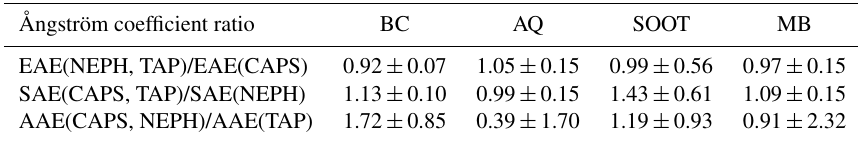
Table 12. Ensemble averages and standard deviations for the instrument-to-instrument ratios of the Ångström exponents (EAE, SAE, AAE) derived from multiple instruments relative to those derived from single instruments as a